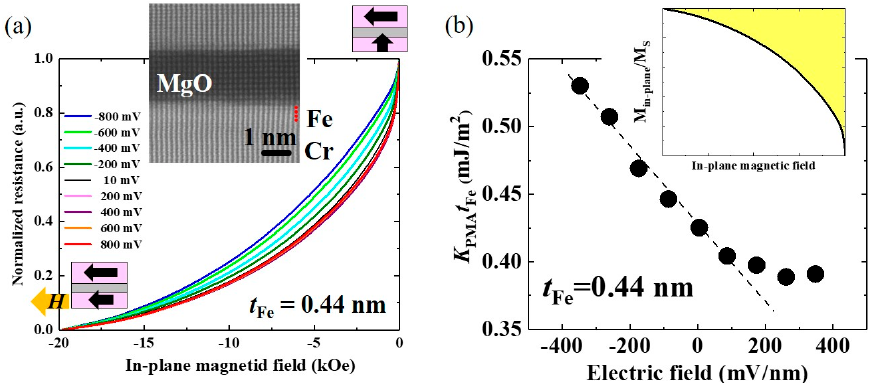
Figure 11. ( a ) Bias voltage dependence of normalized tunnel magnetoresistance (TMR) curves measured under in-plane magnetic fields for an orthogonally magnetized MTJ consisting of Cr/ultrathin Fe (0.44 nm)/MgO/Fe (10 nm). The inset shows a cross-sectional TEM image of the MTJ.